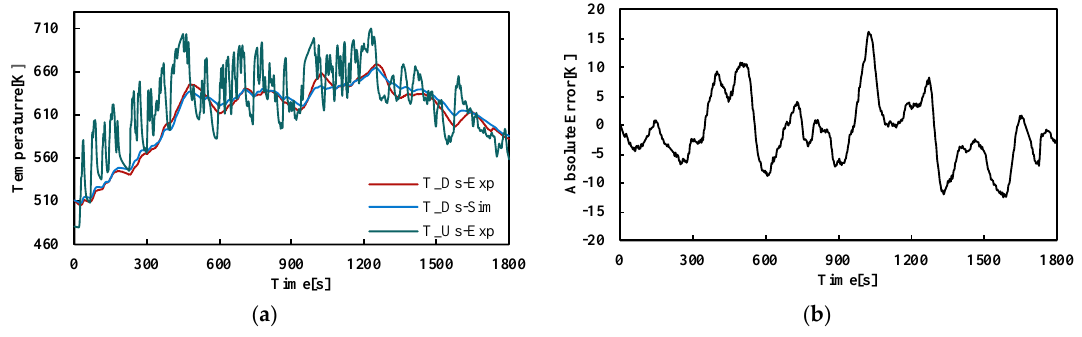
Figure 6. Comparison of simulation and experimental results. ( a ) Temperature vs. time; and ( b ) absolute error.